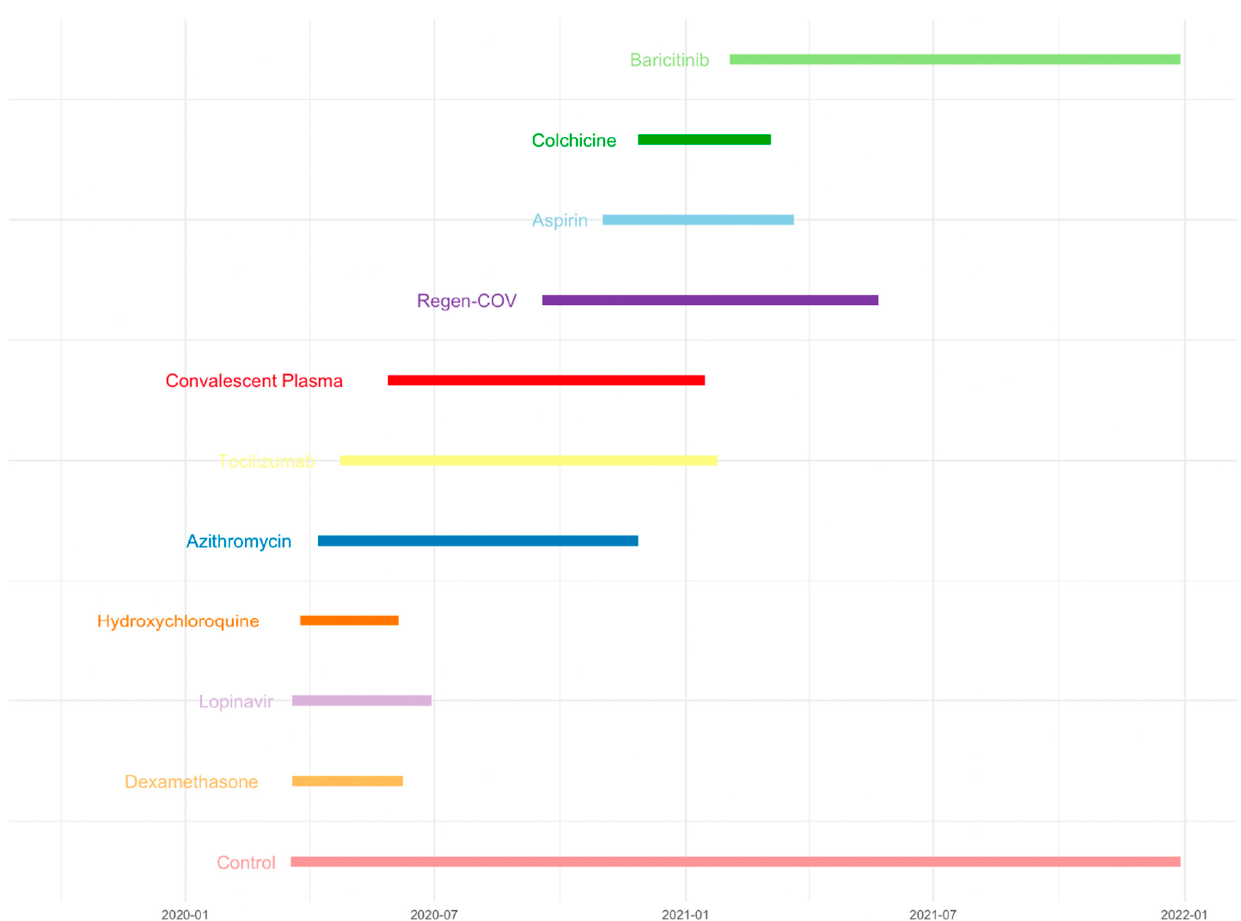
Figure 1. RECOVERY platform trial. RECOVERY is investigating whether treatment with Dexamethasone, Lopinavir-Ritonavir, Hydroxychloroquine, Azithromycin, Tocilizumab, Convalescent Plasma, Regen-COV, Aspirin, Colchicine, or Baricitinib prevents death in patients with COVID-19. In this trial, patients are randomly allocated between one or more treatment arms, each to be given in addition to the usual standard of care in the participating hospital. The study is dynamic, and treatments are added and removed as results and suitable treatments become available. Note that a common control group is shared for all treatments.